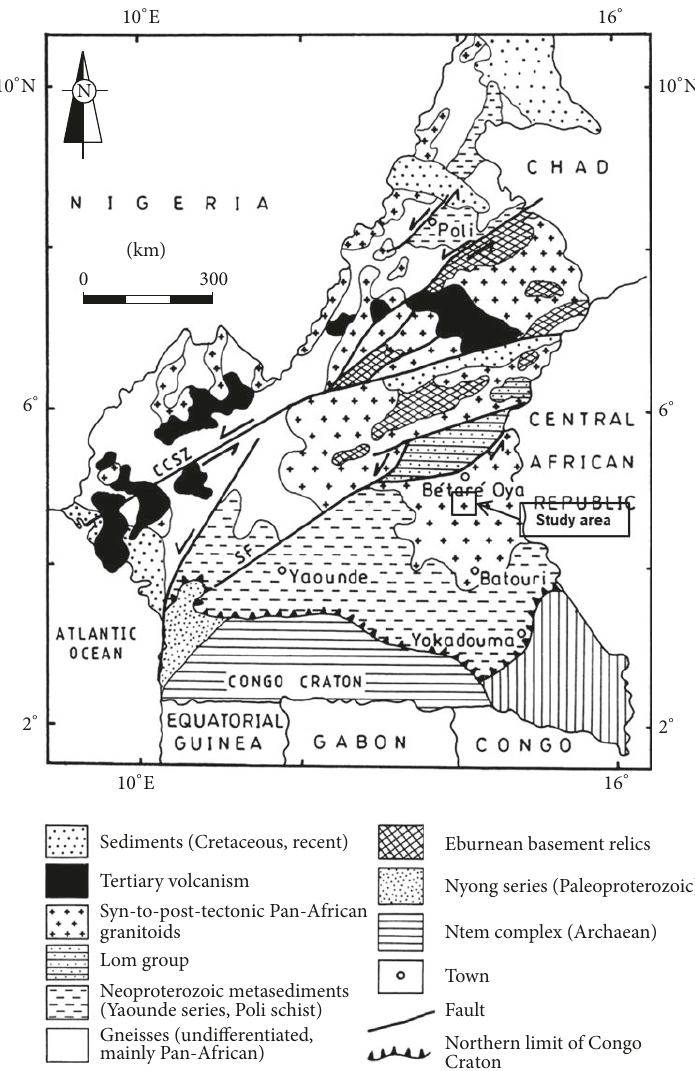
Figure 2: Regional structural setting of Cameroon (reproduced and modified from Suh et al., 2006, under the public domain).